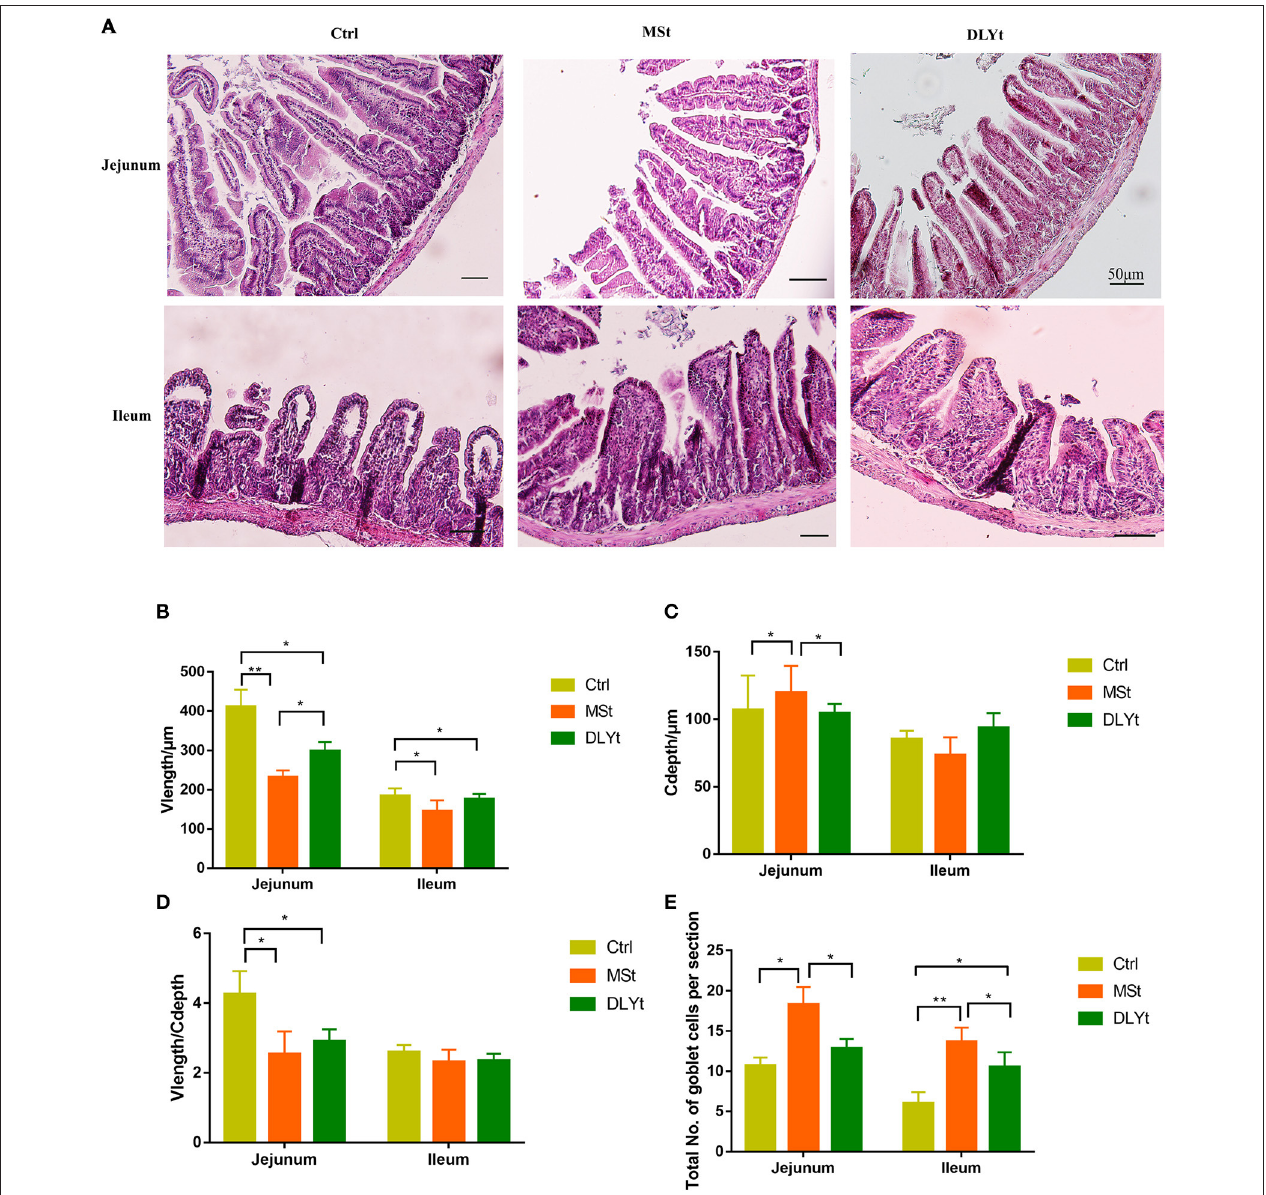
FIGURE 2 | Effect of FMT on intestinal form, cell composition, and immune factors during cold exposure. (A) The ileum intestinal tissue H&E-stained sections of control, the Mashen pigs (MSt) and Duroc-Landrace-Yorkshire pigs (DLYt) group ( n = 7/group), and the jejunum intestinal tissue H&E-stained sections of the control, the MSt and DLYt group ( n = 7/group). (B–E) Results of intestinal morphology of each group. Detection results of intestinal goblet cell number ( n = 7/group). (* P < 0.05, ** P < 0.01, and *** P < 0.001, Duncan’s multiple range test). *** means extremely